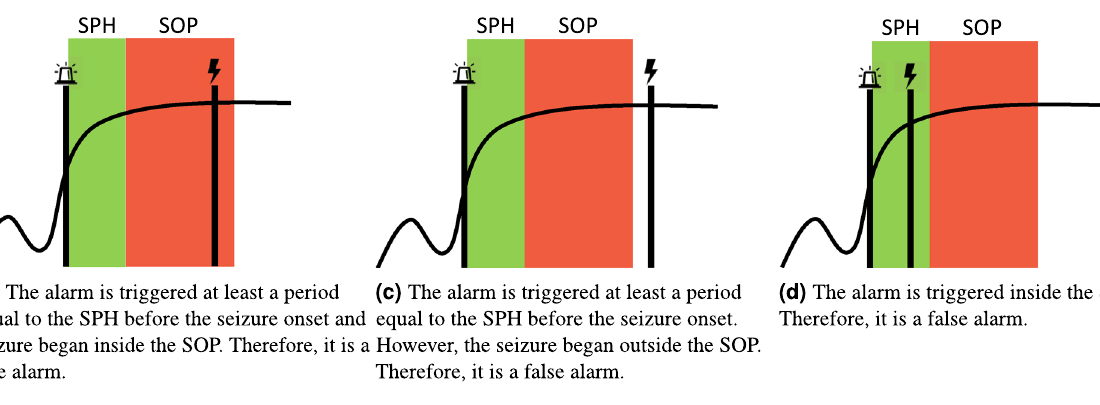
Figure 2. Representation of how to train a seizure prediction model and the requirements needed to be considered a true